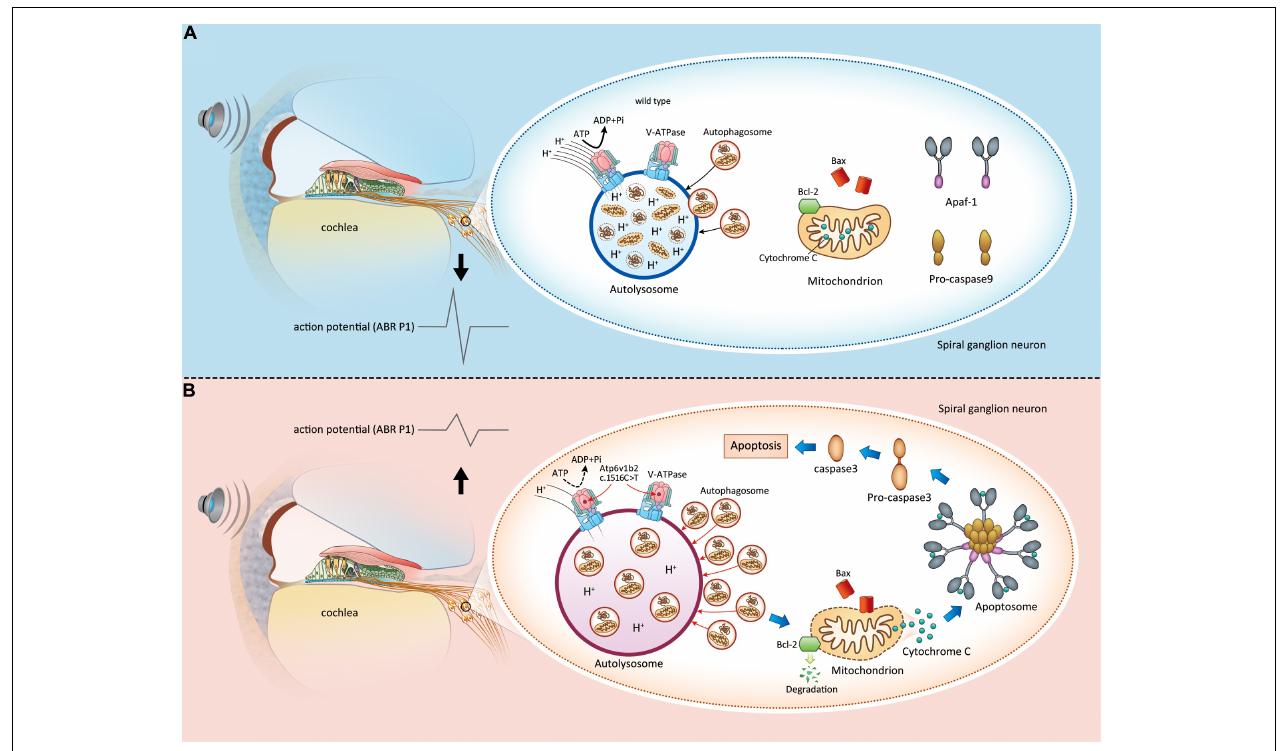
FIGURE 6 | Apoptosis induced by lysosome dysfunction and autophagic flux block in spiral ganglion neurons (SGNs) causes hearing impairment in Atp6v1b2 Arg 506 ∗ / Arg 506 ∗ mice. (A) In WT mice, V-ATPases in the SGNs maintain the acidic environment by pumping protons into the lumen of lysosomes. It is a process that requires ATP hydrolysis. When autophagosomes enter the lysosomes, the intracellular components carried by autophagosomes are degraded. The magnitude of peak I (P1) amplitudes of ABR correlates with the number and synchronous firing rate of the SGN fibers. (B) Atp6v1b2 c.1516 C > T affects the assembly of V-ATPases and their role in pumping protons into the lumen of lysosomes. Thus, the pH in the lysosomes increases, and the activity of acid hydrolases decreases. Under this circumstance, the autophagosomes are not effectively degraded and they accumulate in the lysosomes, which further affects the entrance of other autophagosomes. When the anti-apoptotic member of Bcl-2 family, Bcl-2, detects the acid environment disequilibrium in the lysosomes and autophagosome accumulation within the cytoplasm, it itself degrades, which in turn activates Bax/Bak complexes. Bax binds to and decreases the permeability of the mitochondrial membrane, leading to cytochrome C release. Cytochrome C binds to its partner Apaf-1 to induce the formation of a caspase-9-activating protein complex known as an apoptosome, which directly activates caspase-3, the ultimate initiator of the apoptosis process. Once apoptosis occurs in the SGNs, the hearing is